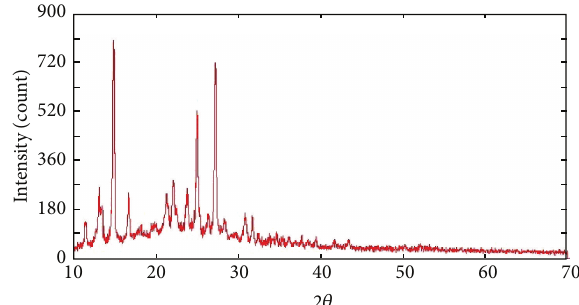
Figure 3: X-ray powder diffraction patterns of the compound [L 2 H]. functional groups. Therefore, molecular models of complexes were demonstrated. Physical dimension of the molecules helped out to demonstrate the changes occurring during their topological assemblies. Energy minimization is used to